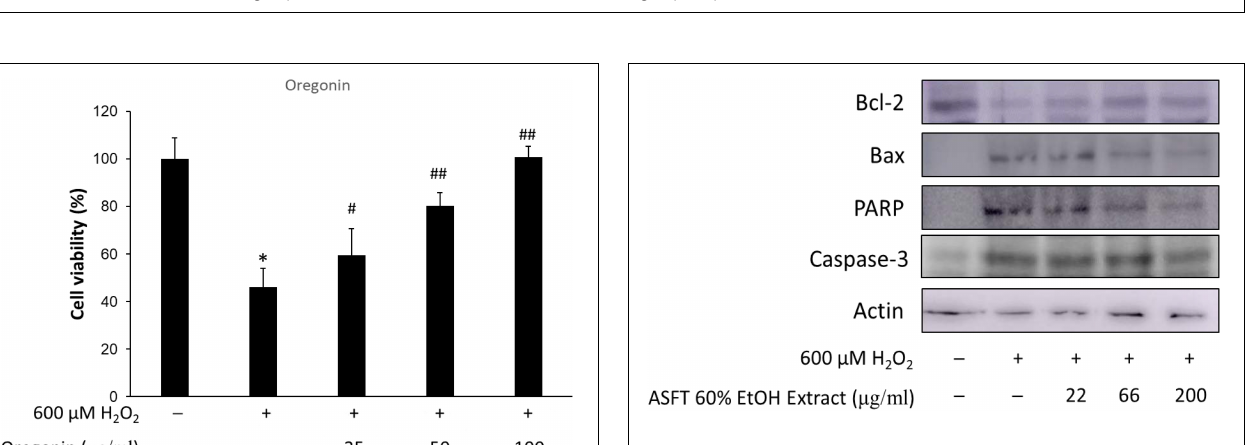
FIGURE 2 | Inhibitory effects of 60% ethanol extract from Alnus sibirica Fisch. ex Turcz (ASFT) on oxidative stress in cells. The cells were pre-incubated with the indicated dose of ASFT ( µ g/ml, w/v) and treated with 600 µ M H 2 O 2 . Cell viability was calculated as described in “Materials and Methods.” Data were expressed as mean ± SD. * P < 0.05 vs normal group. # P < 0.05 and ## P < 0.01 vs H 2 O 2 -treated group. +, present; –, absent.